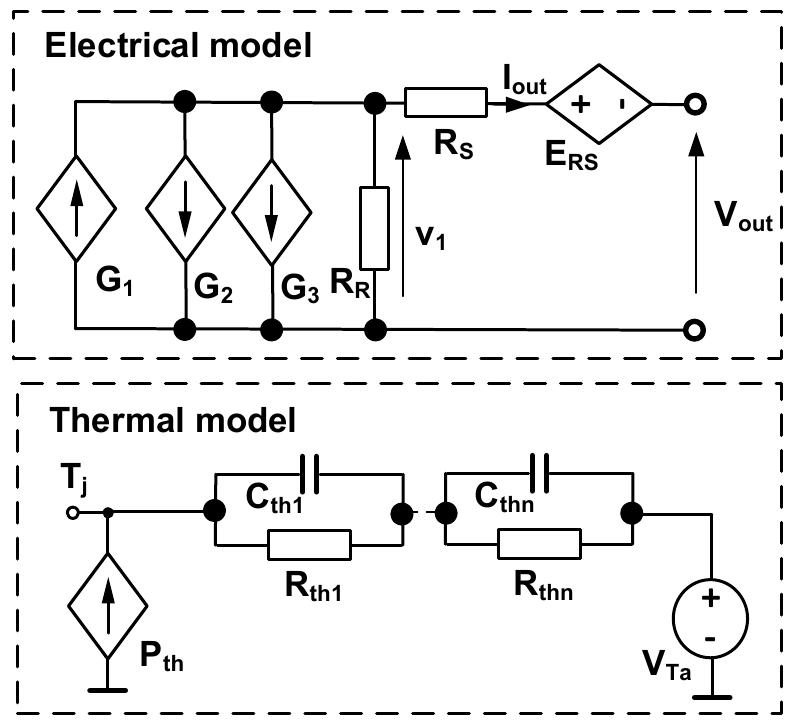
Figure 4. The network representation of the solar cell